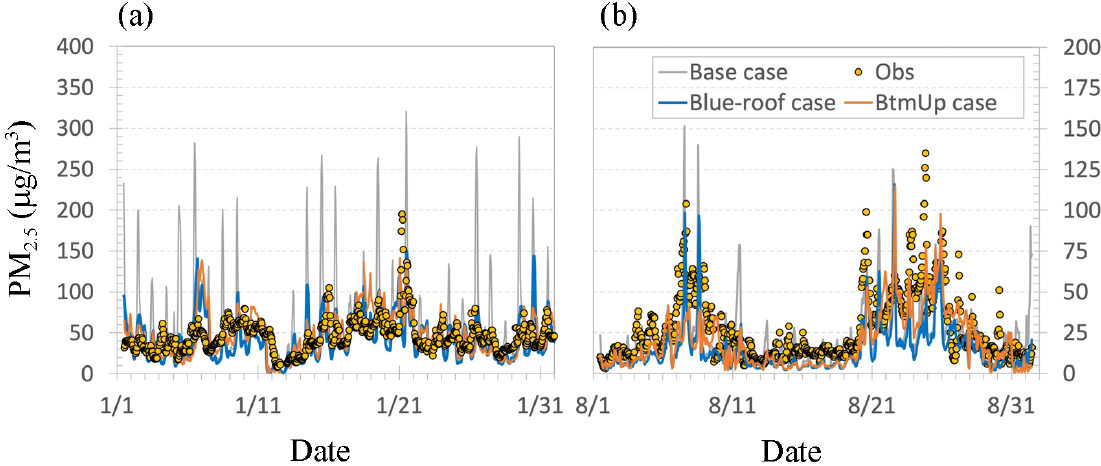
Figure 7. Time series of PM 2 . 5 at station CN_1379A (22 ◦ 31 (cid:48) 16.0 (cid:48)(cid:48) N, 113 ◦ 22 (cid:48) 36.8 (cid:48)(cid:48) E) – Zhongshan: (a) January and (b) August. Atmos. Chem. Phys., 21, 12895–12908,